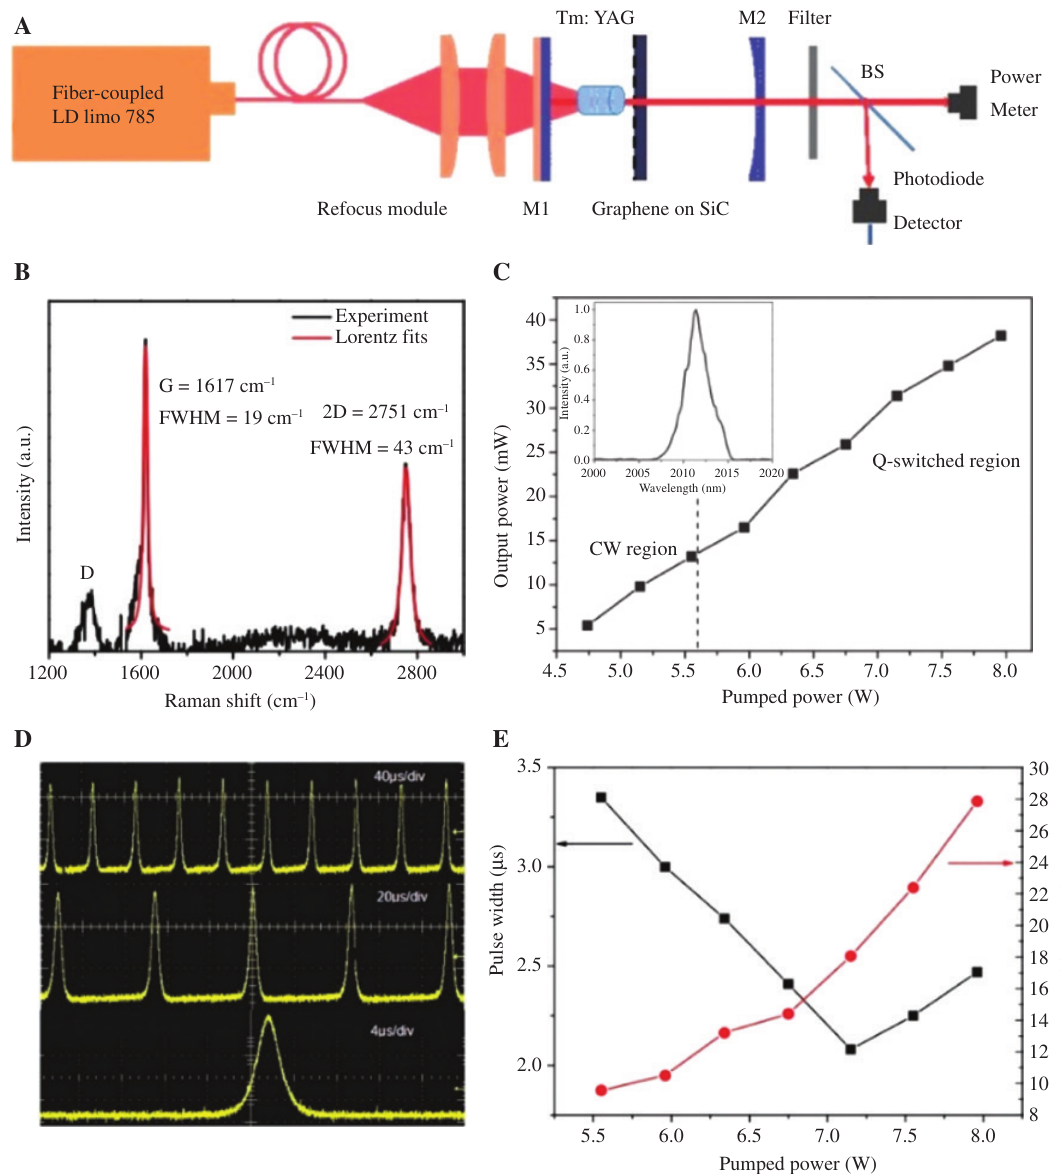
Figure 16: Performance the first graphene Q-switcher Tm:YAG laser. (A) Schematic of the graphene Q-switched Tm:YAG laser. (B) Raman spectrum of graphene sample. (C) Output power vs. incident pump power of the graphene Q-switched laser, with its spectrum inserted. (D) Pulse traces in different time scales. (E) Pulse width and repetition rate vs. incident pump power. Reproduced with permission [275]. Copyright 2012, Optical Society of